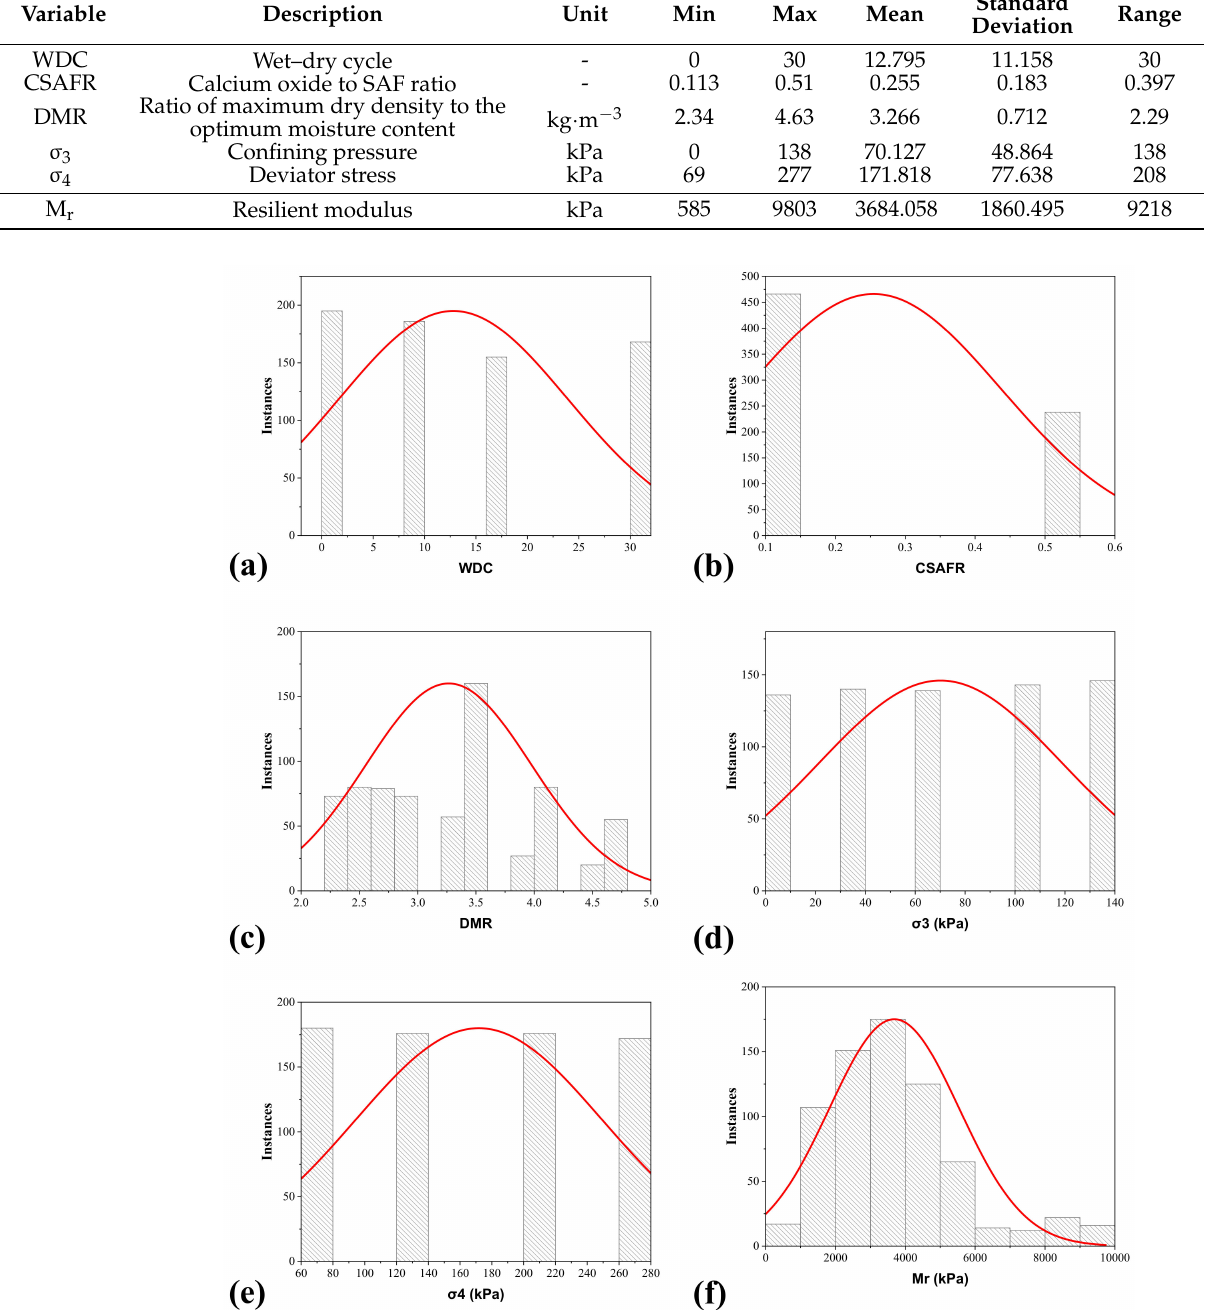
Figure 1. Distribution histogram of the variables considered in the current study: ( a ) number of wet–dry cycles (WDC), ( b ) calcium oxide to SAF (silica, alumina, and ferric oxide compounds in the cementitious materials) ratio (CSAFR), ( c ) ratio of maximum dry density to the optimum moisture content (DMR), ( d ) confining pressure ( σ 3 ), ( e ) deviator stress ( σ 4 ), and ( f ) target parameter, i.e., resilient modulus (M r